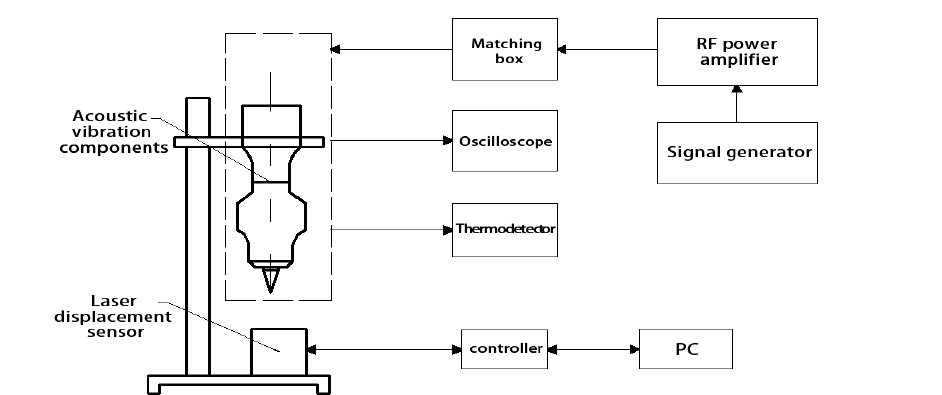
Figure 3. PV70A Ultrasonic Impedance Analyzer.